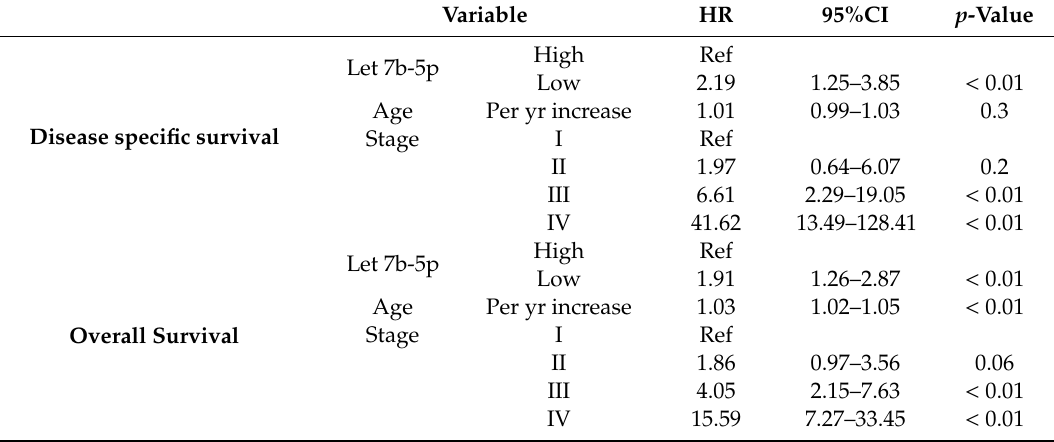
Table 1. Multivariate Cox model of factors associated with survival